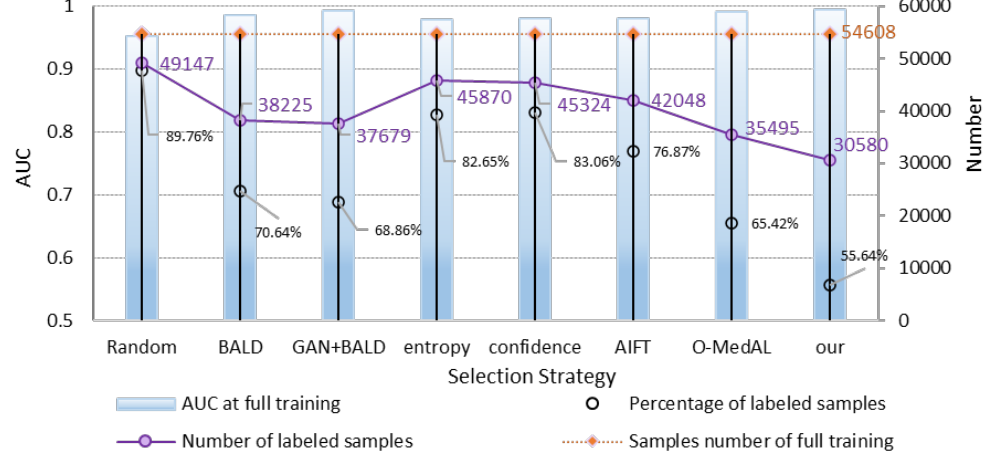
Figure 10. Performance and training sample number comparison of the full-training and proposed framework.